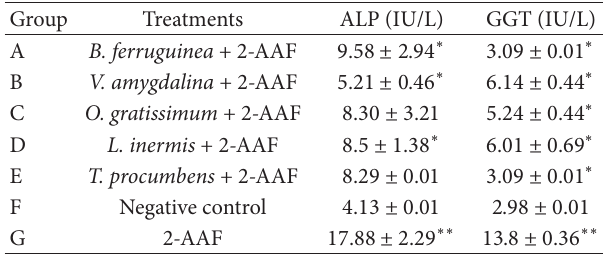
Table 2: ALP and GGT concentration in rats treated with the plant extracts and